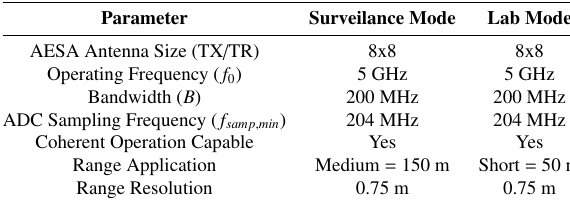
Figure 4. MIMO Radar (AESA - MIMO Mode) where each colour represents an orthogonal waveform transmitted from a TR Module